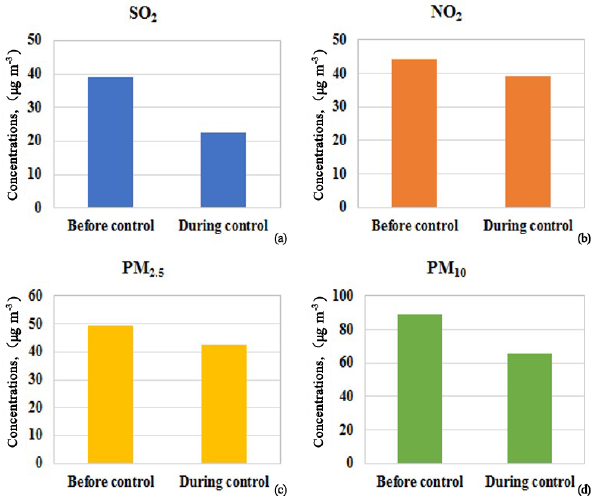
Figure 11. Comparison between concentrations of major air pollu- tants in Jiaxing before and after the campaign under same meteoro- logical conditions.